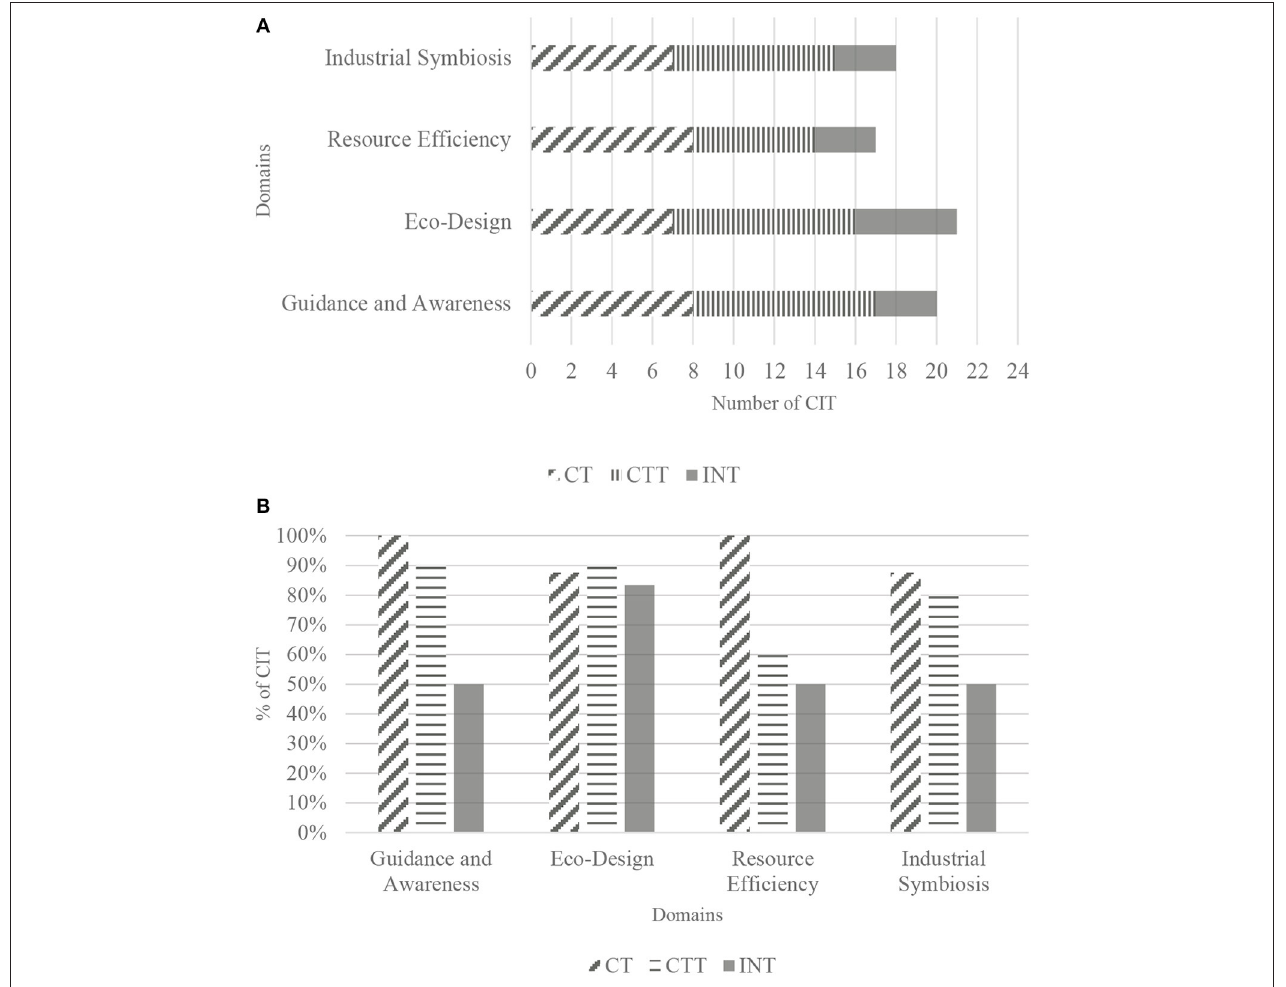
FIGURE 2 | (A) Abundance of competences in each mapped domain. (B) Distribution of the technological interface center groups by domain of